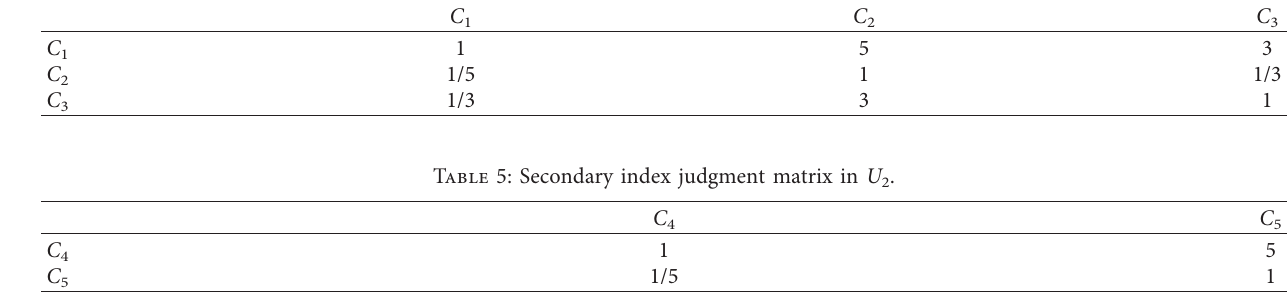
Table 4: Secondary index judgment matrix in U